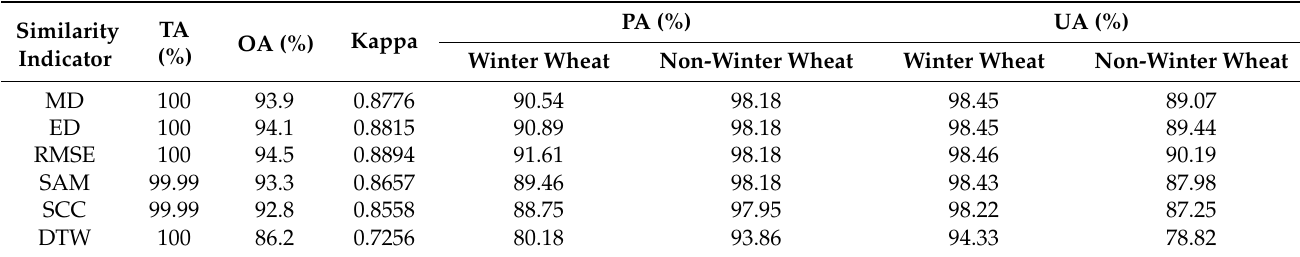
Figure 7. Extraction and mapping results of winter wheat using different similarity indicators, ( a ) MD, ( b ) ED, ( c ) RMSE, ( d ) SAM, ( e ) SCC, ( f ) DTW. Table 3. Optimization of the threshold parameters of the winter wheat extraction